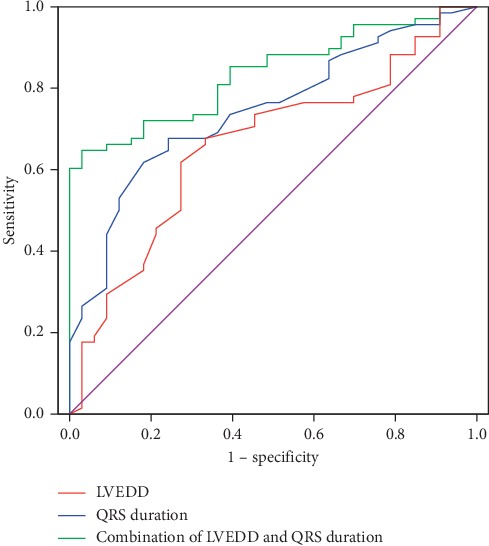
Receiver operating characteristic curve for LVEDD (red line), QRS duration (blue line), and combination of LVEDD and QRS duration (green line) in predicting response. Combination of LVEDD and QRS duration versus LVEDD alone AUC (0.836 vs. 0.662, Z = 3.058, P=0.002). Combination of LVEDD and QRS duration versus QRS duration alone AUC (0.836 vs. 0.744, Z = 2.309, P=0.021). LVEDD versus QRS duration AUC (0.662 vs. 0.744, Z = 1.323, P=0.186). LVEDD: left ventricular end-diastolic dimension; AUC: area under the curve.